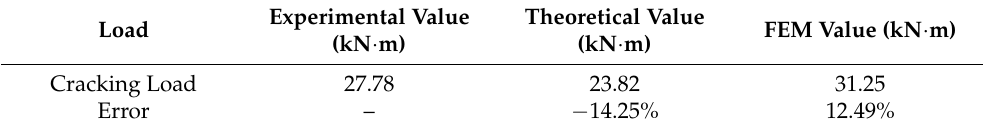
Table 4. Crack load of the hollow